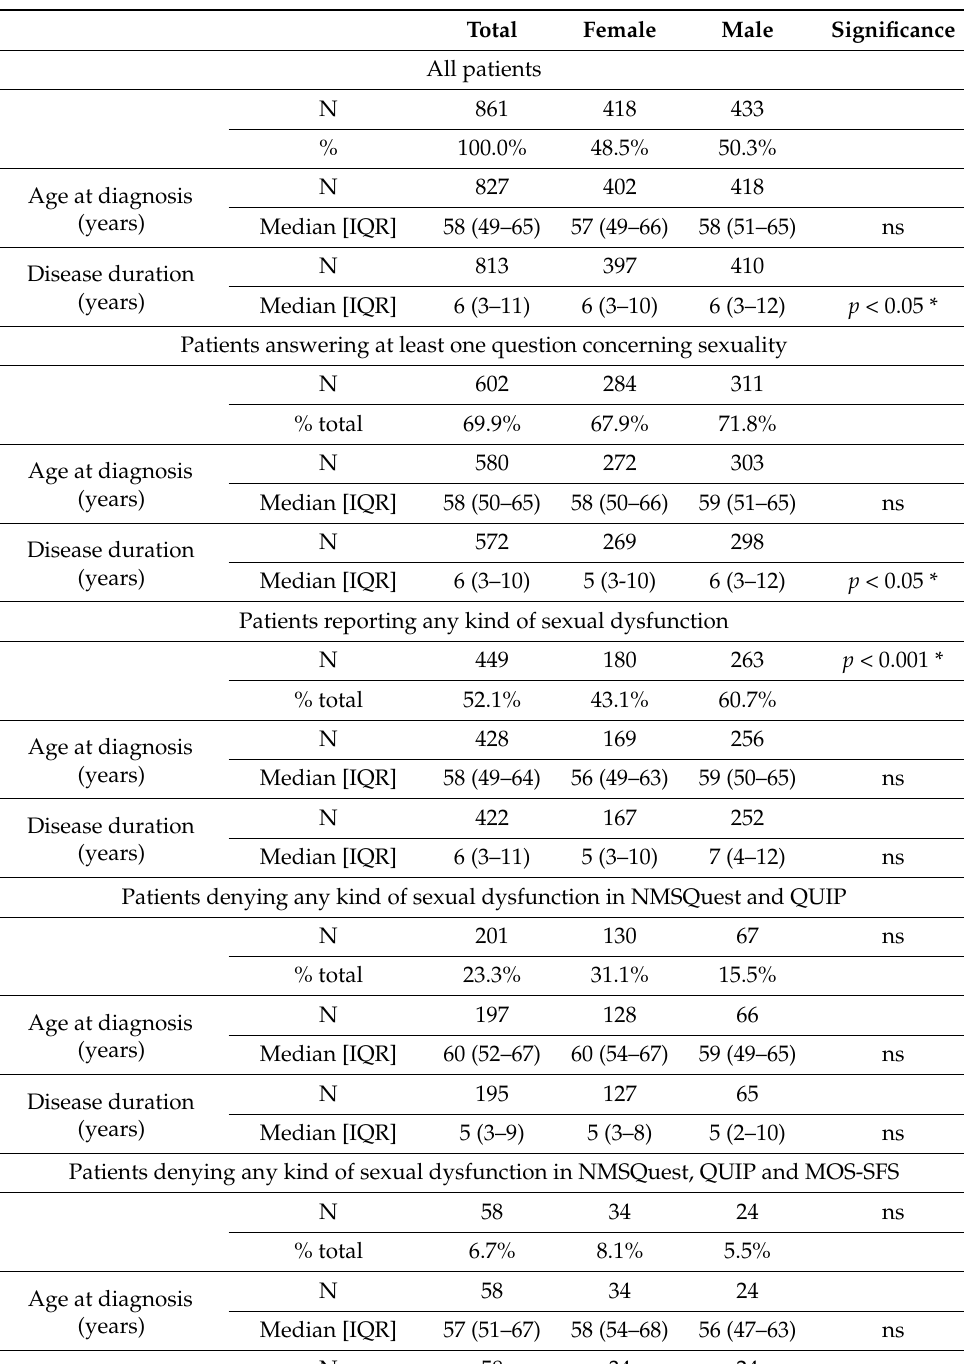
Table 1. Demographics of sexual dysfunctions in